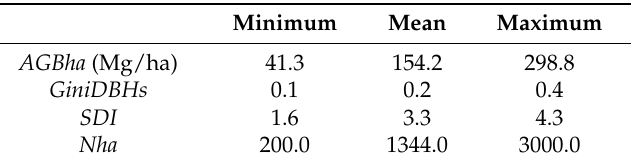
Figure 1. Location of the 12 field plots (red dots) in Hadeland municipality. Table 1. Summary of the field data at the plot